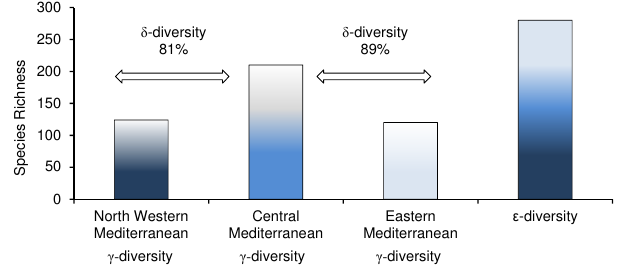
Fig. 6. Nematode species richness at regional and macro-regional spatial scale: γ diversity (as total number of species retrieved from each region), δ diversity between regions and the ε diversity (as total species richness in the Mediterranean Sea).